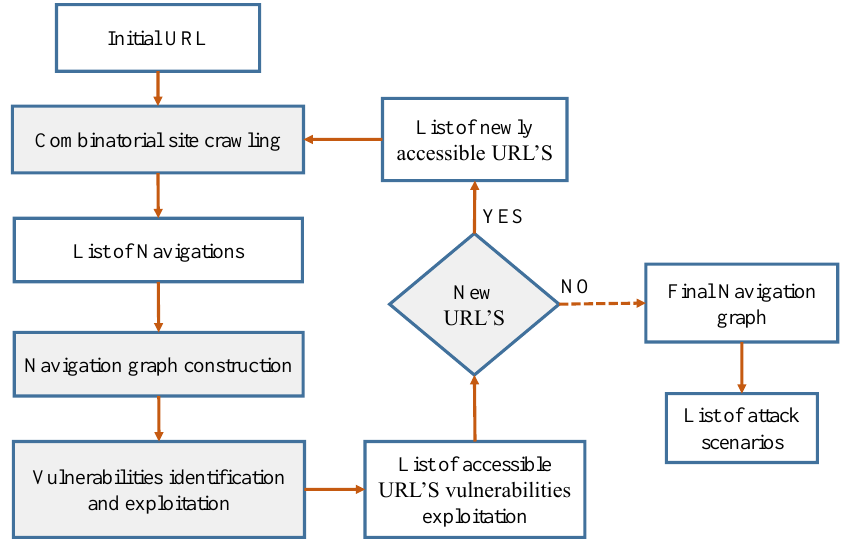
Figure 5. Vulnerabilities’ identification using black-box